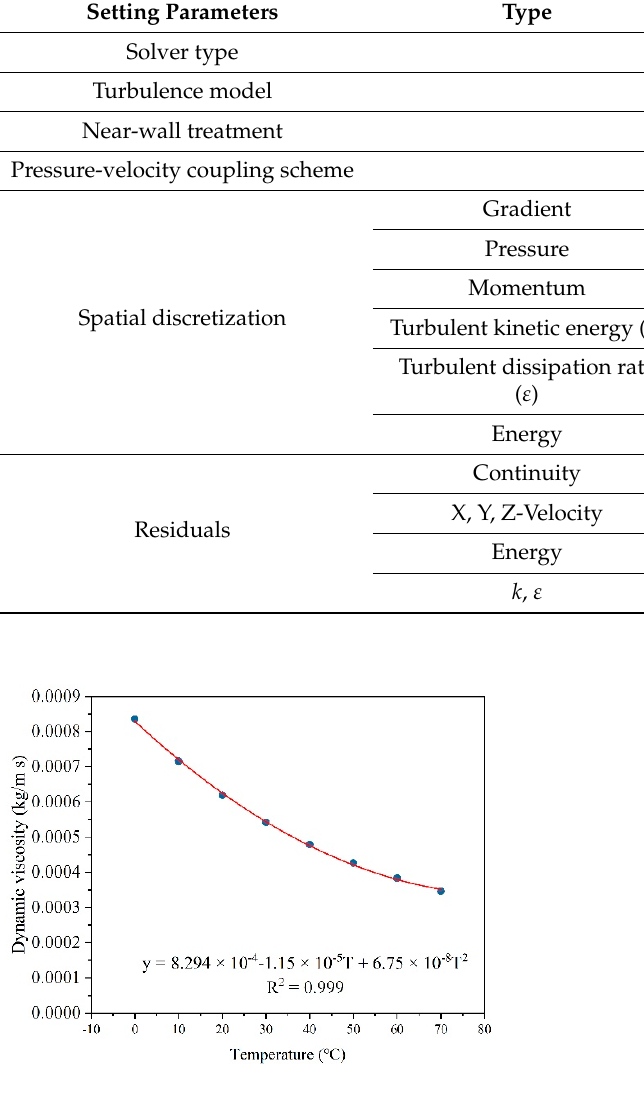
Figure 4. Correlation between liquid dynamic viscosity and temperature.